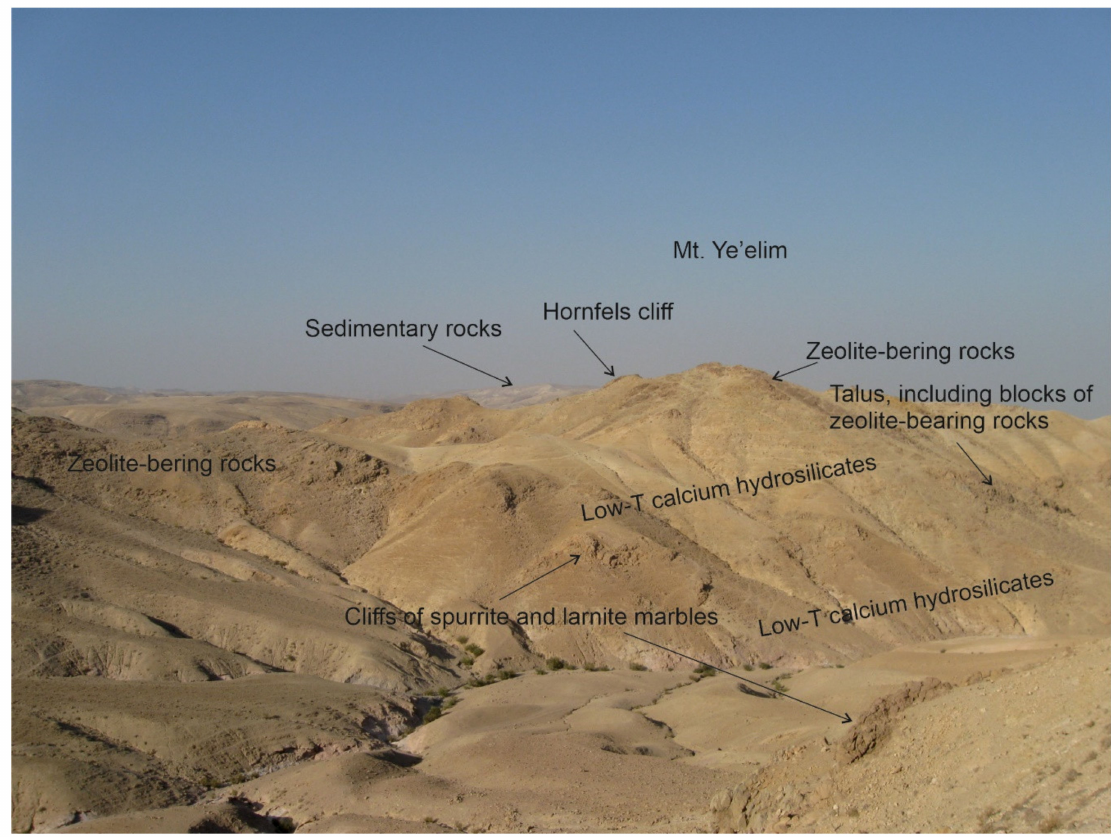
Figure 2. The Hatrurim Basin, Mt. Ye’elim, eastern slope composed of pyrometamorphic rocks and products of their alteration. Relative height of Mt. Ye’elim is about 80 m. Ordinary sedimentary rocks are seen in the